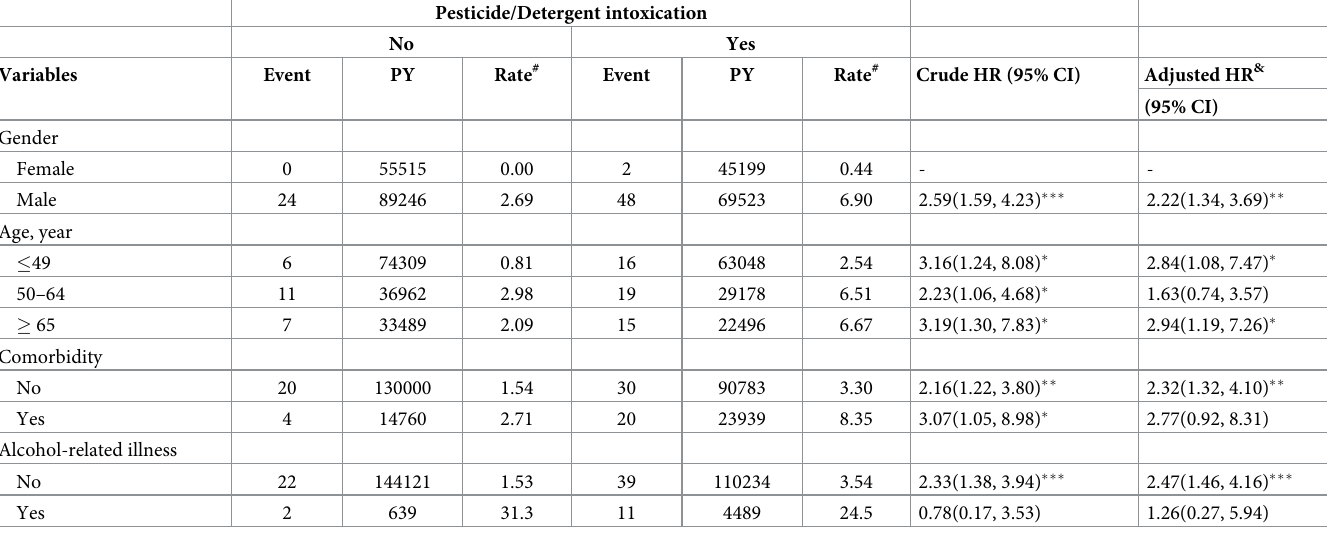
Table 3. Incidence and hazard ratio of esophageal cancer between patients with and without pesticide/detergent intoxication.